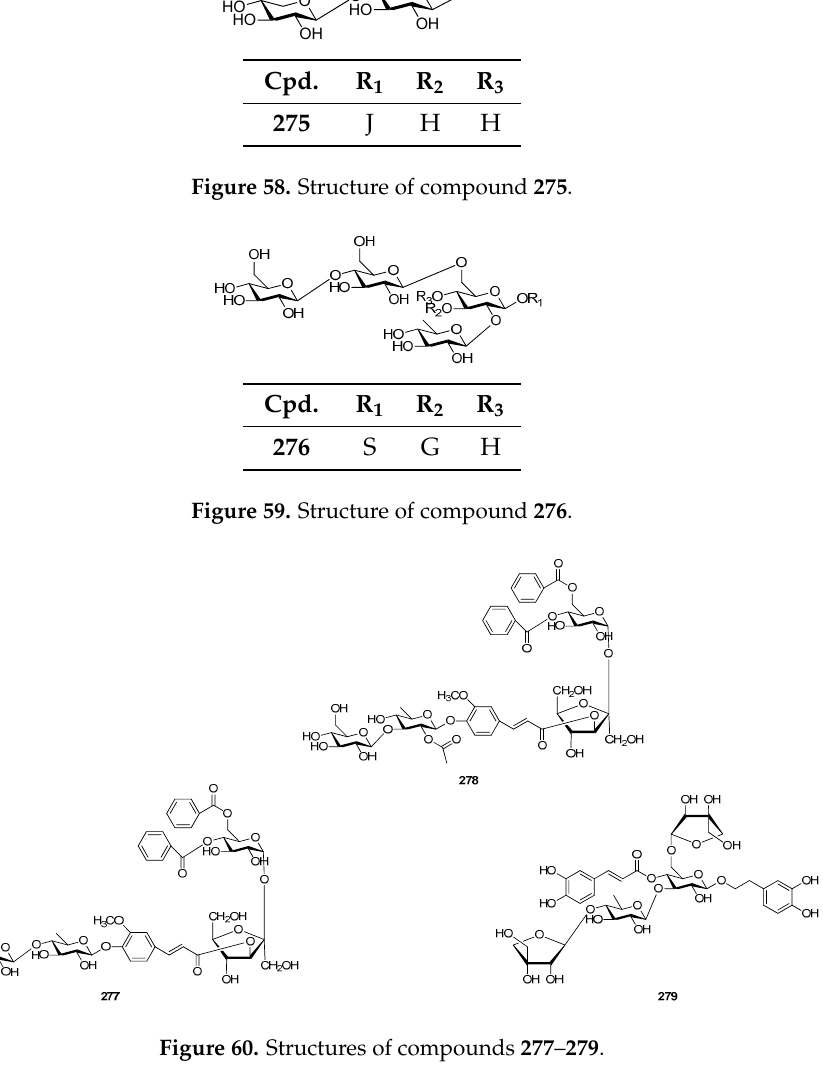
Figure 60. Structures of compounds 277 – 279 .